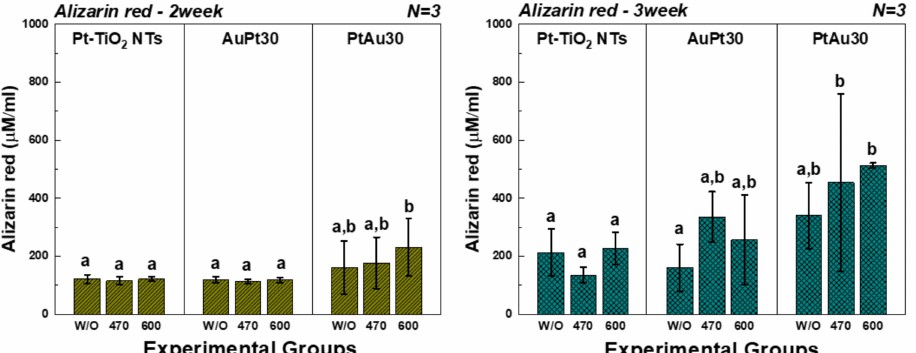
Figure 9. The alizarin red results of hMSCs cultured on Au and Pt multi-coated TiO 2 nanotubes. In the graph, W/O, 470, and 600 designate no irradiation, 470 nm irradiation, and 600 nm irradiation, respectively. Moreover, in each graph, the values of experimental groups with the same lowercase letter (a or b) are not statistically different as determined by one-way ANOVA at α =